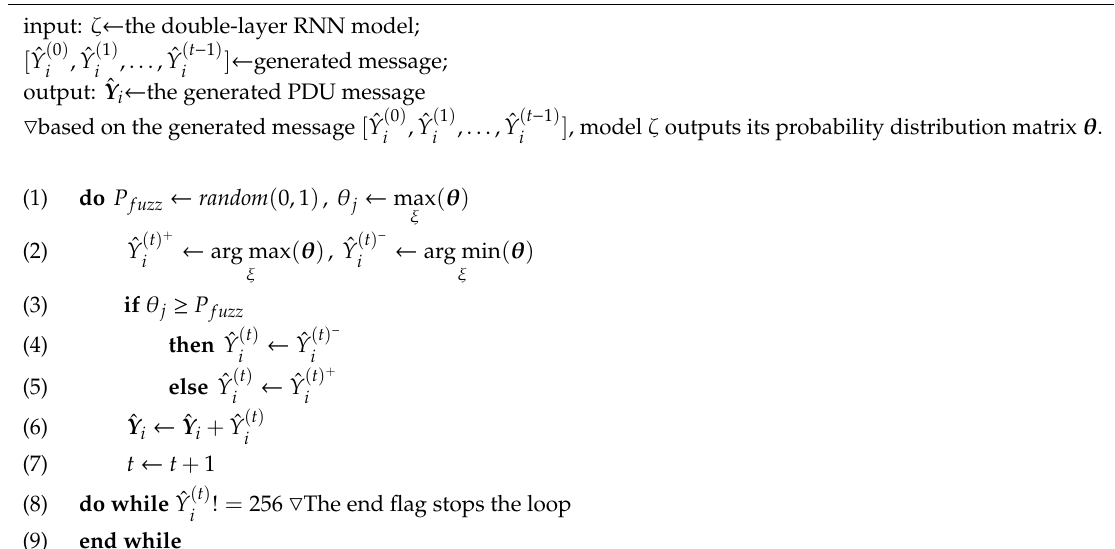
Algorithm 1: Anti-Sample Algorithm